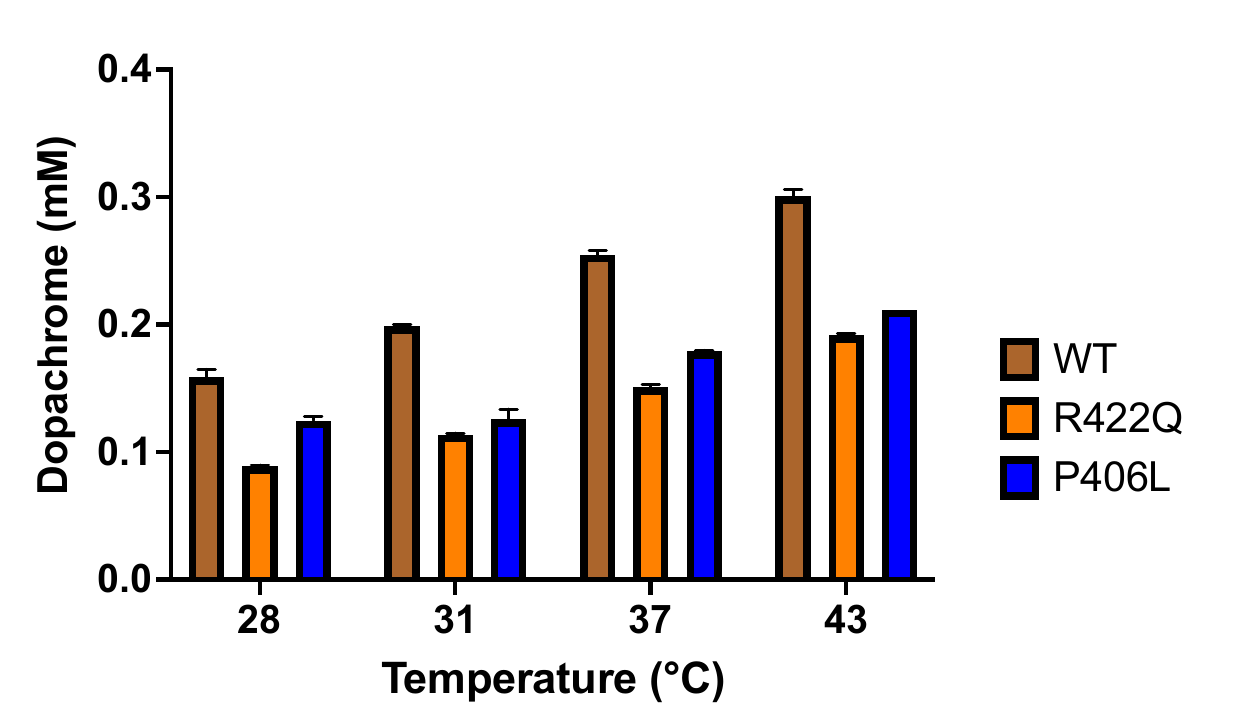
Figure 3. The role of temperature in the production of dopachrome. The diphenol oxidase activities were determined by using 0.05 mg/mL Tyr and 3 mM L-DOPA as a substrate. The absorbance measurements (mOD) of dopachrome production at 475 nm were obtained after running the reactions at the temperature conditions for 30 min. WT, R422Q, and P406L are shown in brown, orange, and blue, respectively. All experiments were performed in duplicates and error bars represent standard deviations.